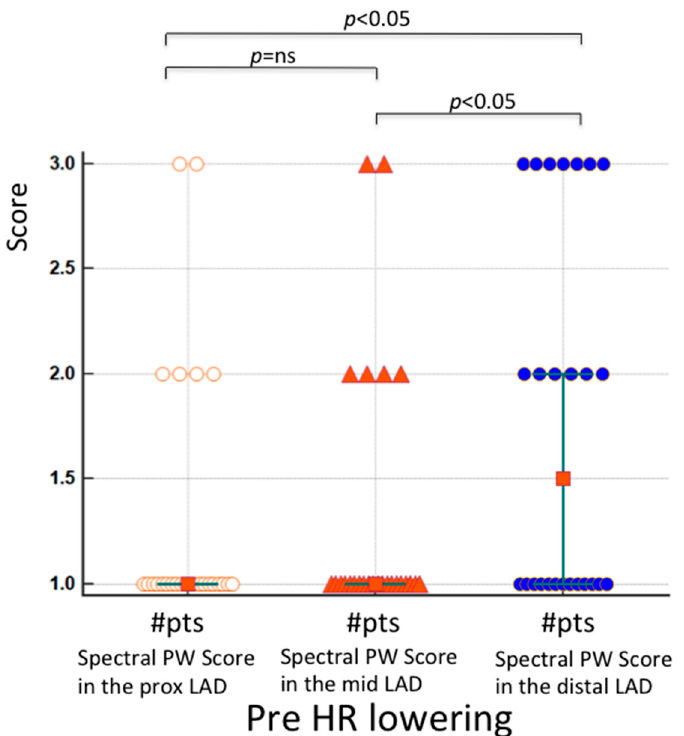
Figure 5. Individual value bar graph showing color-guided PW Doppler quality score pre-HR lowering in the 3 segments of the LAD in 26 patients. The mean rank (1.82 and 1.82) and the median score (1 for both) are similarly low in the two first category (proximal and mid-LAD), while these are significantly higher in the distal LAD (mean rank 2.32 and median 1.5, 95 CI 1–1.5). # = number of patients; white circles= score of proximal LAD segments; orange triangles= score of mid LAD segments; blue circles= score of distal LAD segments.